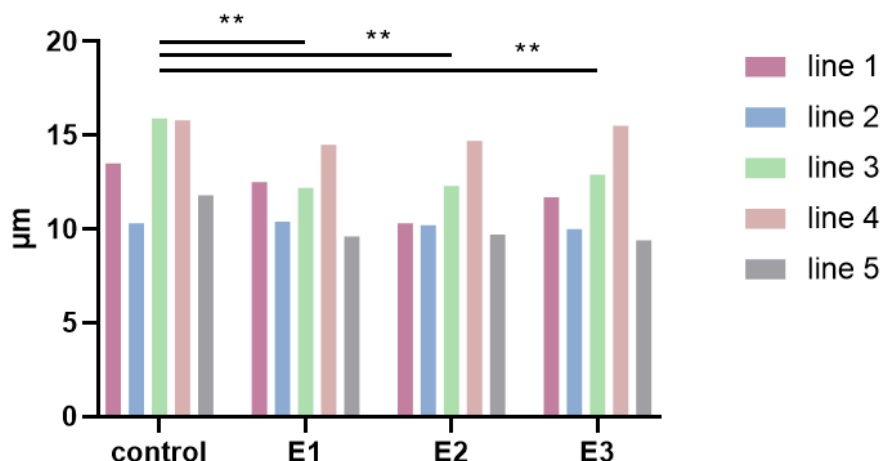
Figure 2. The median of the cell diameter at the end of the 6th passage. The graph demonstrates cell lines 1–5 cultivated in the control (control) and experimental media 1–3 (E1–3). Statistical analysis between pooled data of the control group and pooled data of experimental groups was performed using one-way ANOVA with Fisher’s Least Significant Difference (LSD) post hoc test; ** p < 0.005.